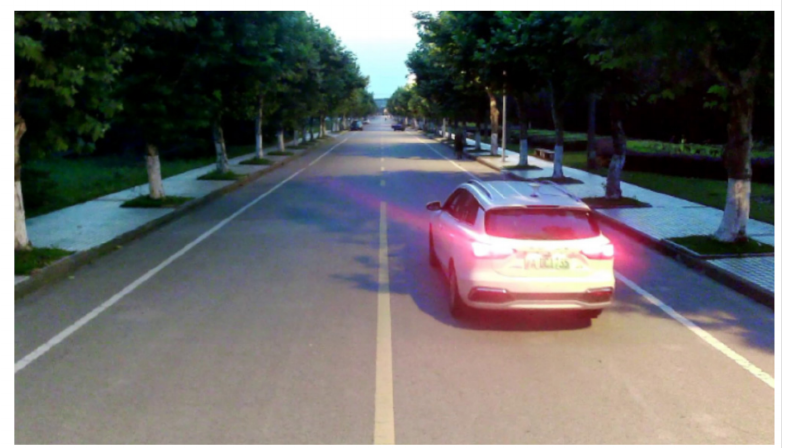
Figure 14. Vehicle tracking experiment in the